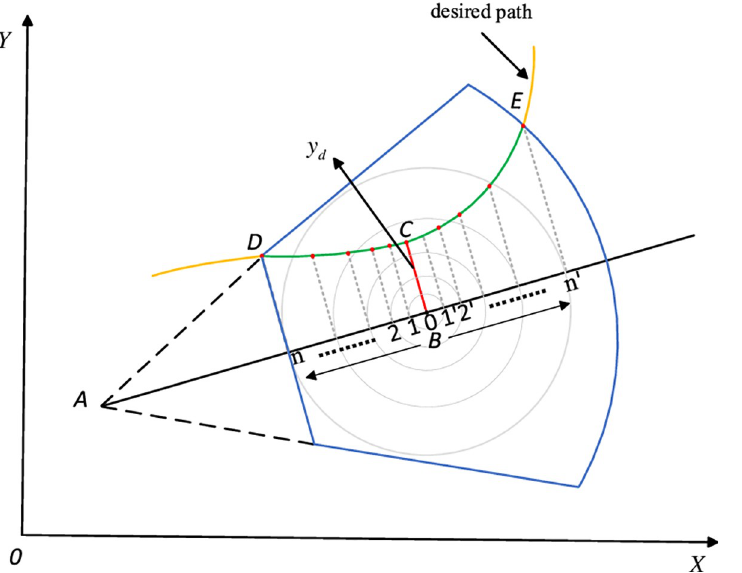
Fig 3. Sight characteristics of